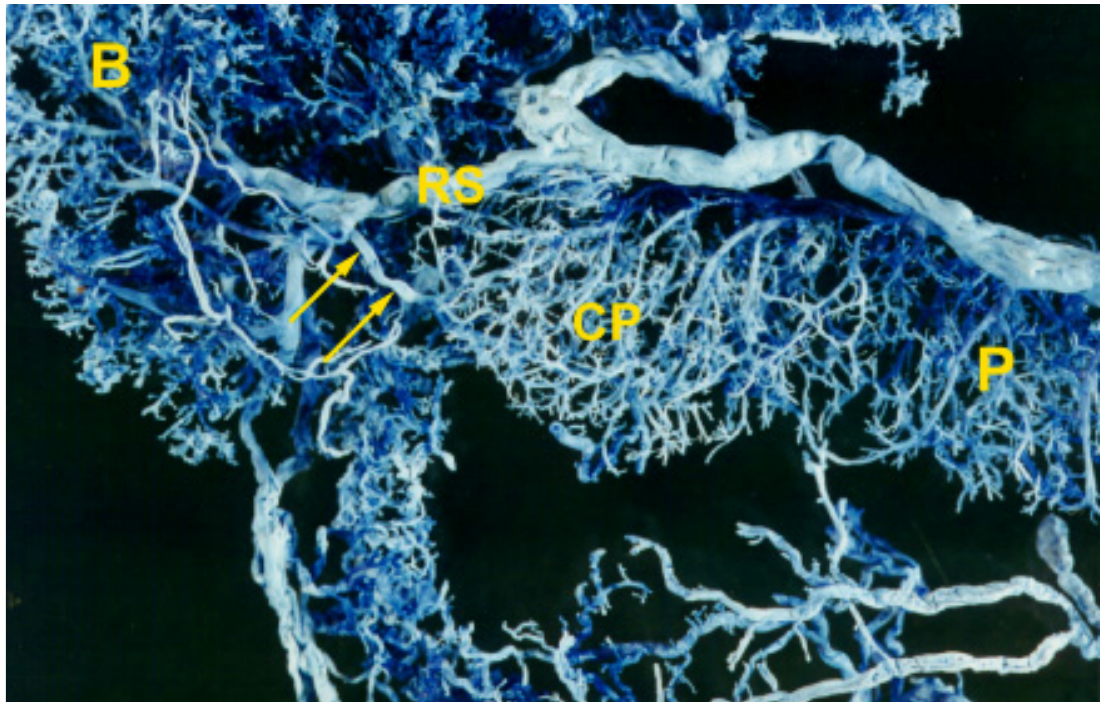
FIGURE 3 - Posterior view of venous pancreatic vascular mold after corrosion of the organic tissue in anatomical pieces of human beings. In this preparation we can observe a pancreatic branch ( arrow ), proceeding from the tail of the pancreas ( P ), draining into a segmentary branch of the splenic vein ( RS )